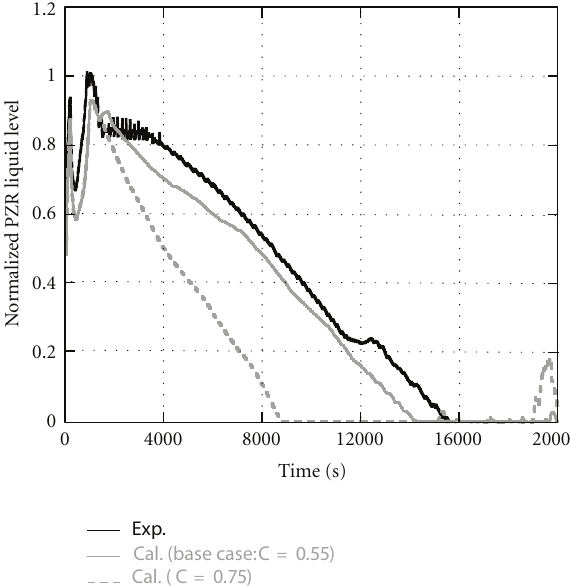
Figure 28: RELAP5 results for PZR liquid level in cases with di ff erent constants C of Wallis CCFL correlation at both all PZR and surge-line